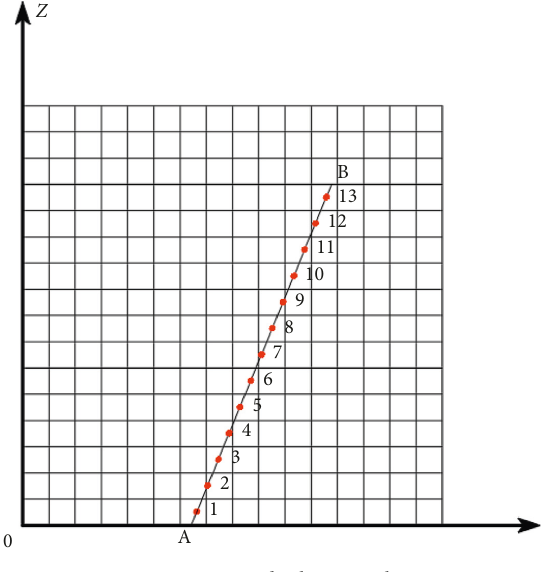
Figure 9: Divide the central axis.